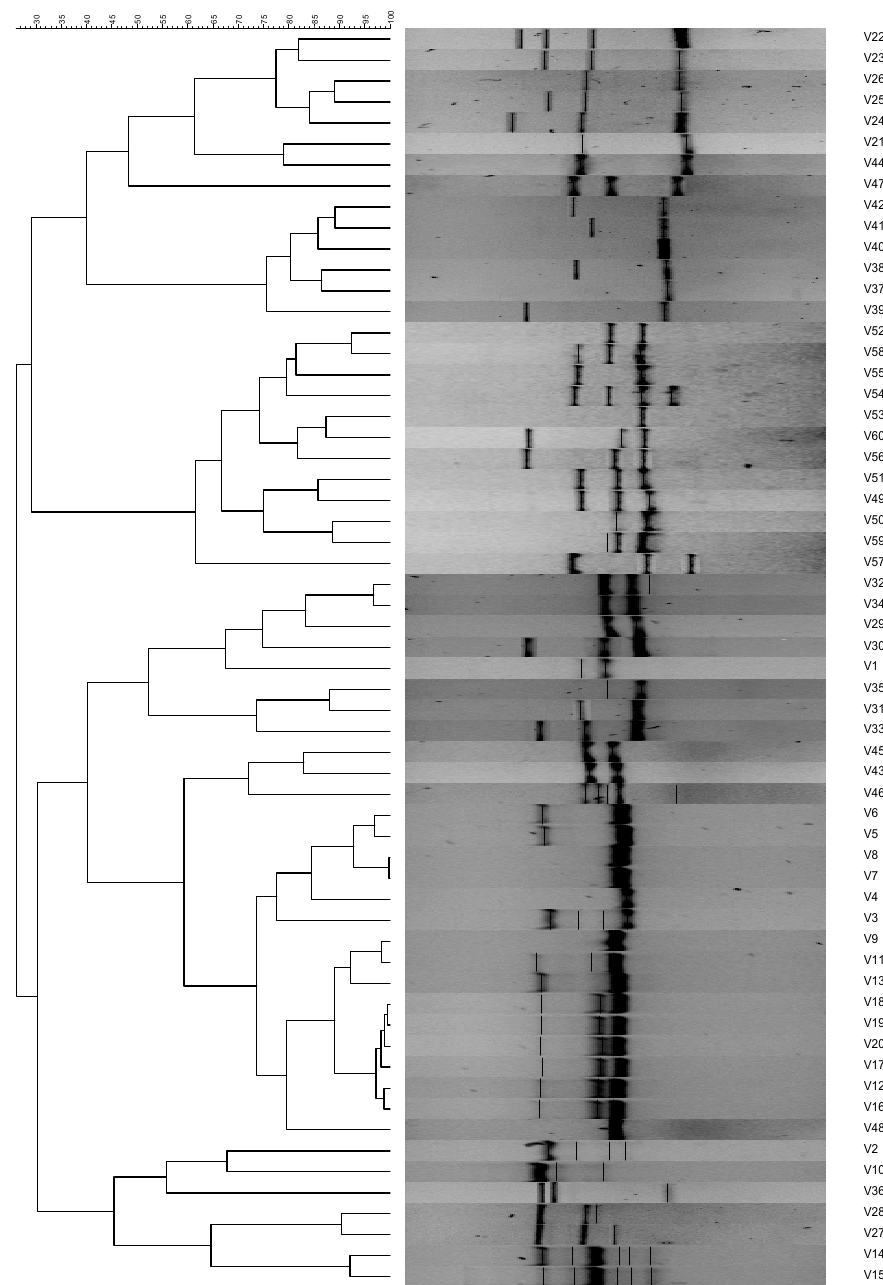
Figure 4. Phylogenetic tree of Vibrio vulnificus isolates (1–60) from RAPD analysis using primer RAPD11, which is able to differentiate the V. vulnificus into 15 clusters and 16 isolates at an 80% similarity level.